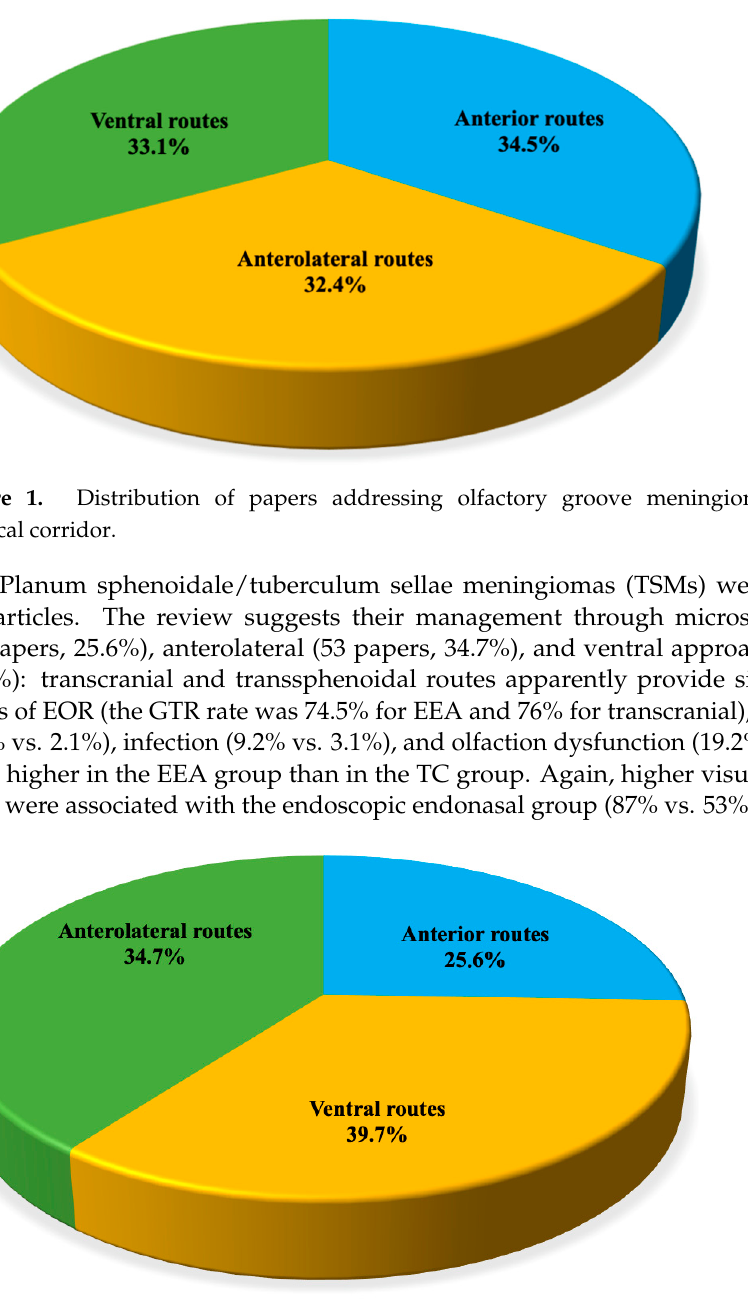
Figure 2. Distribution of papers addressing tuberculum sellae meningiomas (TSMs) divided per surgical corridor.